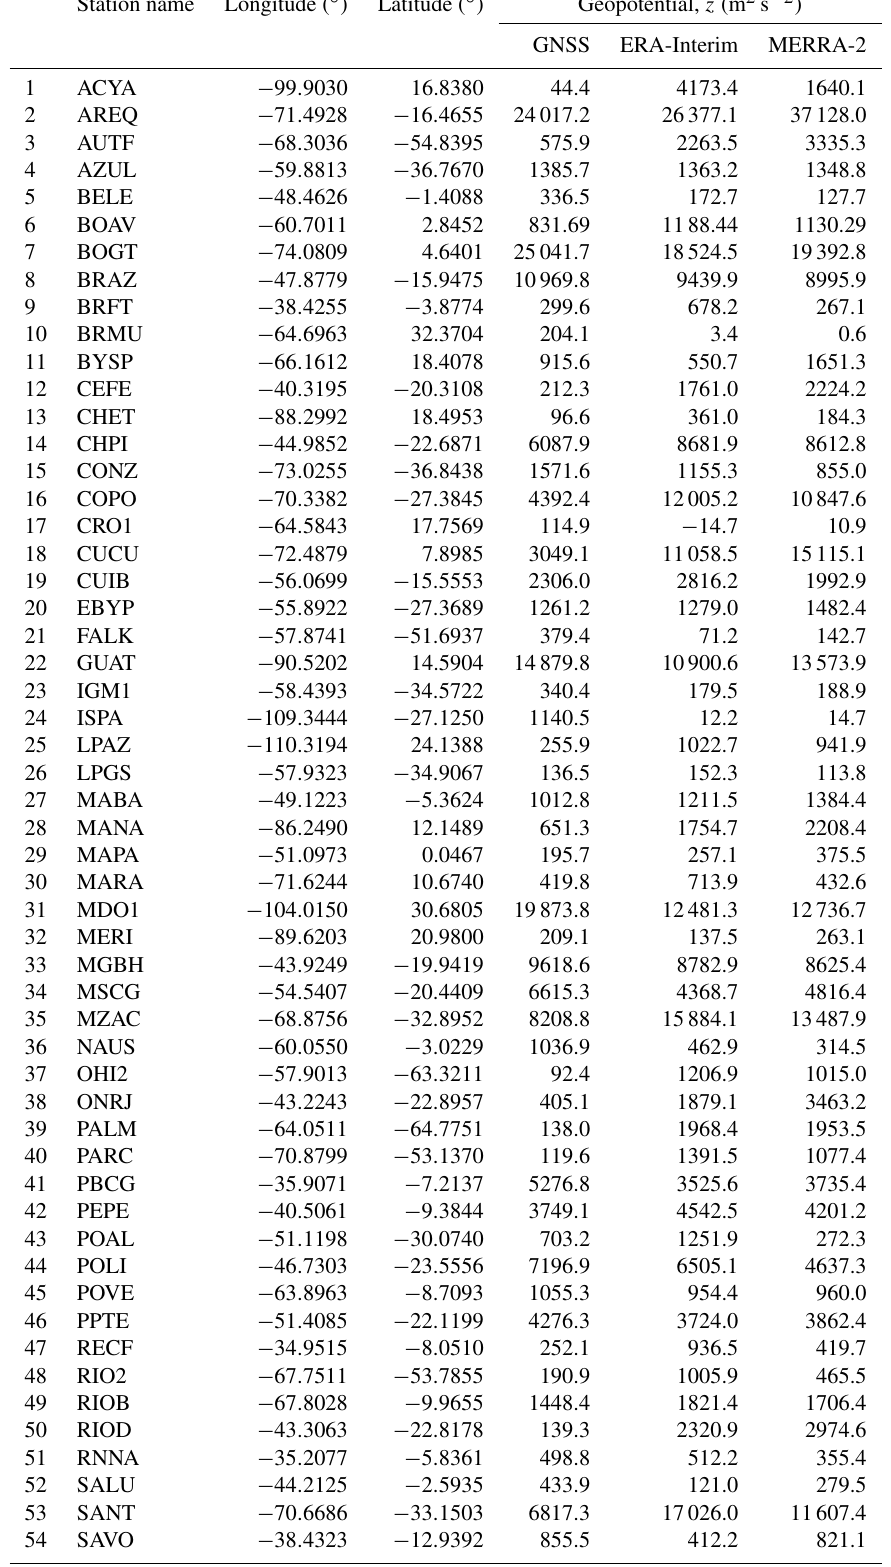
Table 1. Geopotential values at the selected GNSS stations. Values of z ERA-Interim and z MERRA-2 come from a bilinear interpolation of the four gridded values of z around the GNSS